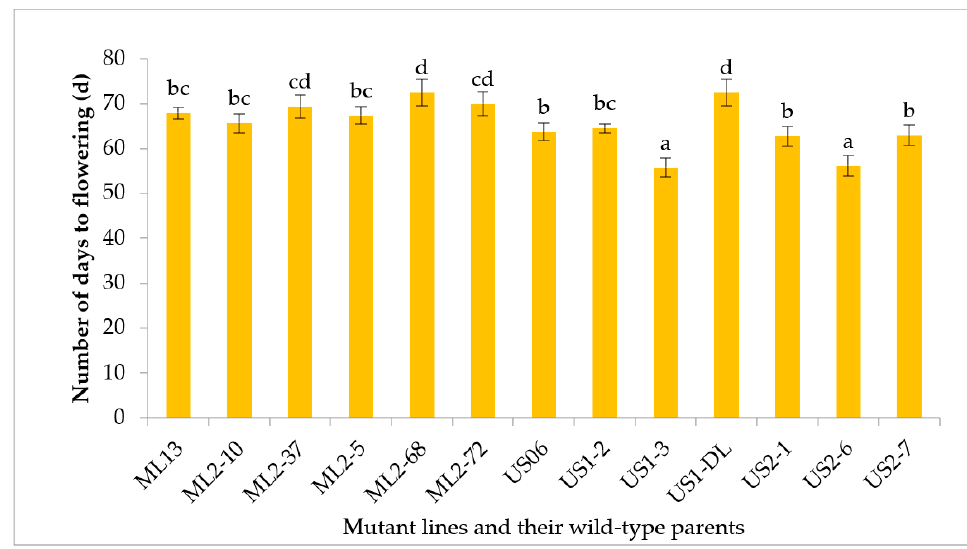
Figure 1. Number of days to flowering (NDF) in 11 sesame mutant lines and their two wildtypes (US06 and ML13). The superscript letters represent the groups according to Duncan’s test.